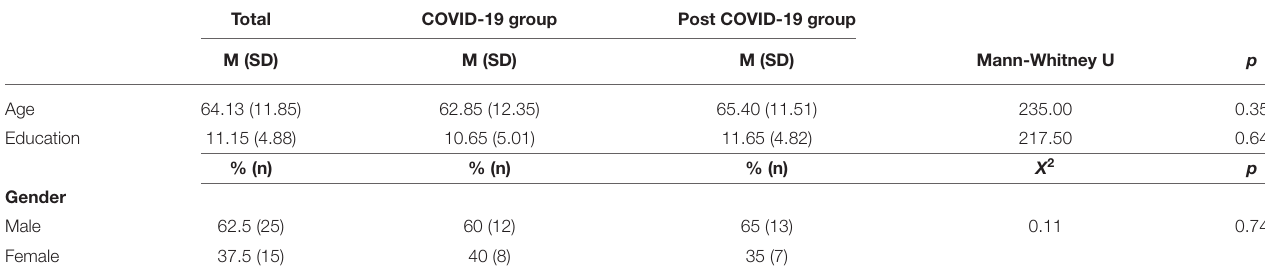
TABLE 1 | Socio-demographic characteristics of the